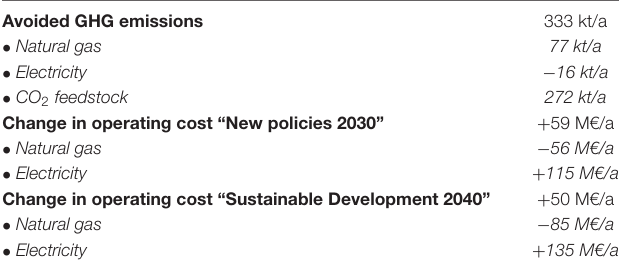
TABLE 6 | Avoided GHG emissions and changes in operating cost for the two different scenarios. Avoided GHG